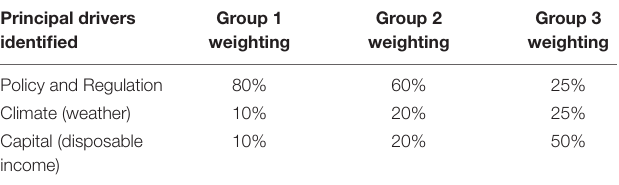
TABLE 2 | Weightings identified by groups and final weighting and assigned dichotomous